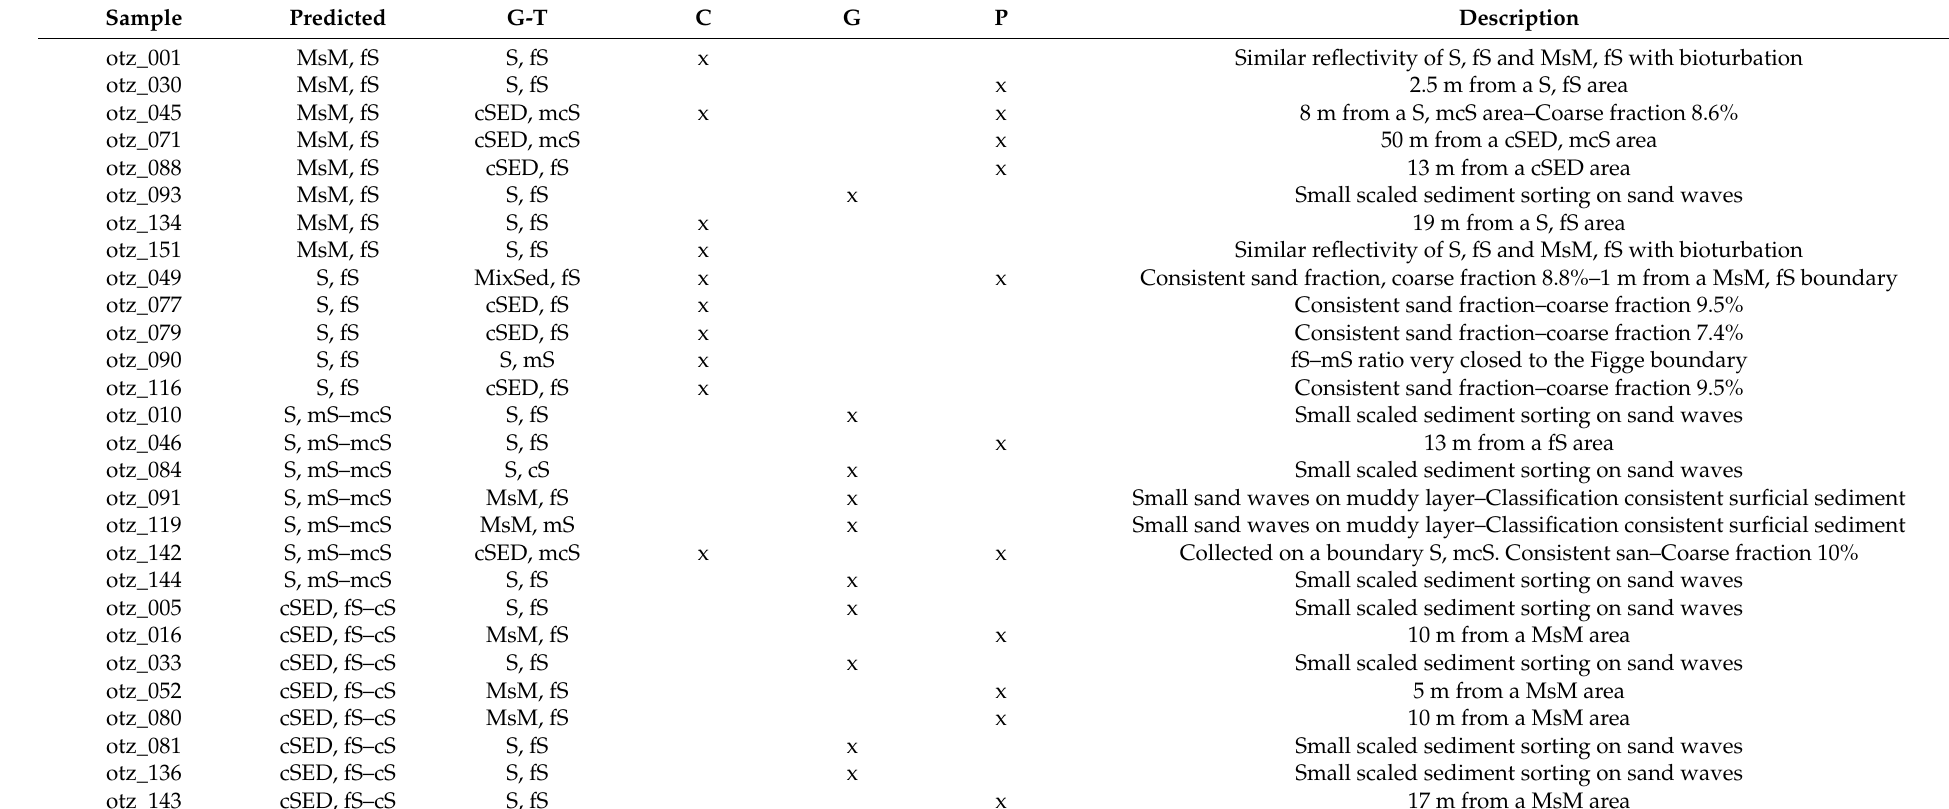
Table 2. Analysis of inconsistencies between ground truths and predicted clusters. G-T = ground-truth; Predicted = clusters resulting from the OBIA verified by ground-truths according to the error matrix in Table 1; C = inconsistency due to classifications; G = inconsistency due to geomorphology; P = inconsistency due to samples position. Other abbreviations refer to sample classes shown in Figure